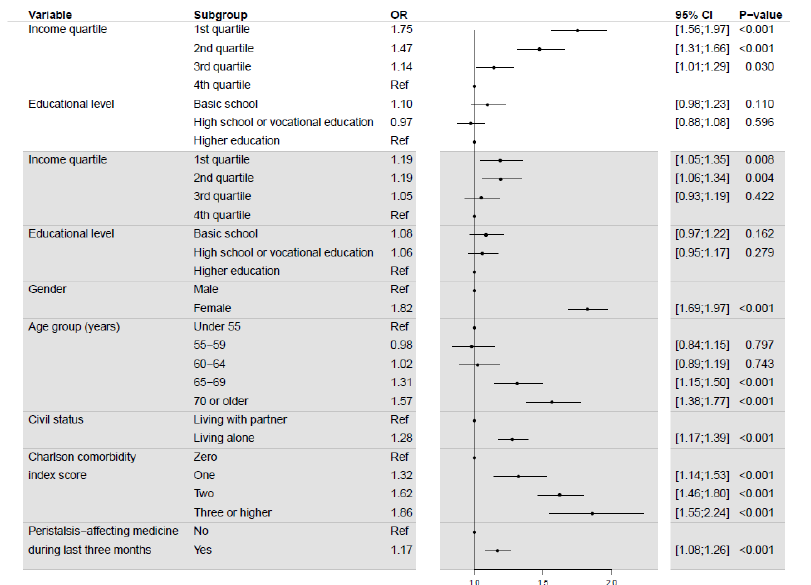
Figure 3. Odds ratios of incomplete colonoscopy due to other reasons from simple (white) and full (grey) logistic regression models. (grey) logistic regression